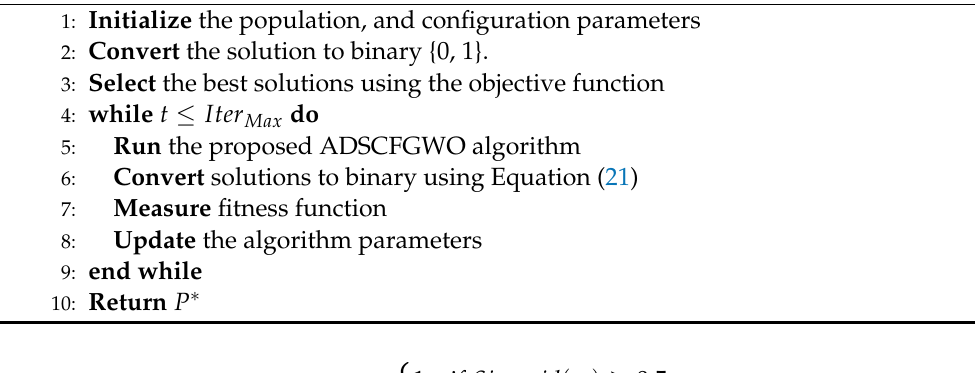
Algorithm 2: The proposed bADSCFGWO feature selection